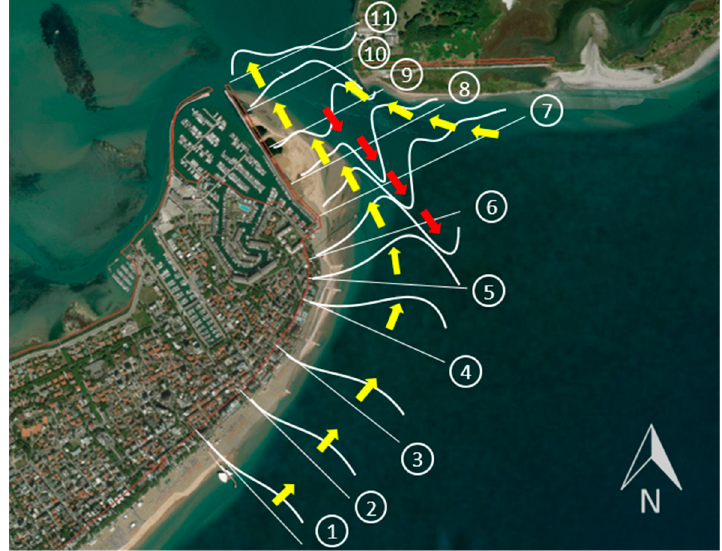
Figure 13. Graphical representation of the sediment fluxes through the numbered sections in the area of the Lignano inlet. The yellow arrows indicate flood directions, while the red arrows indicate ebb directions.